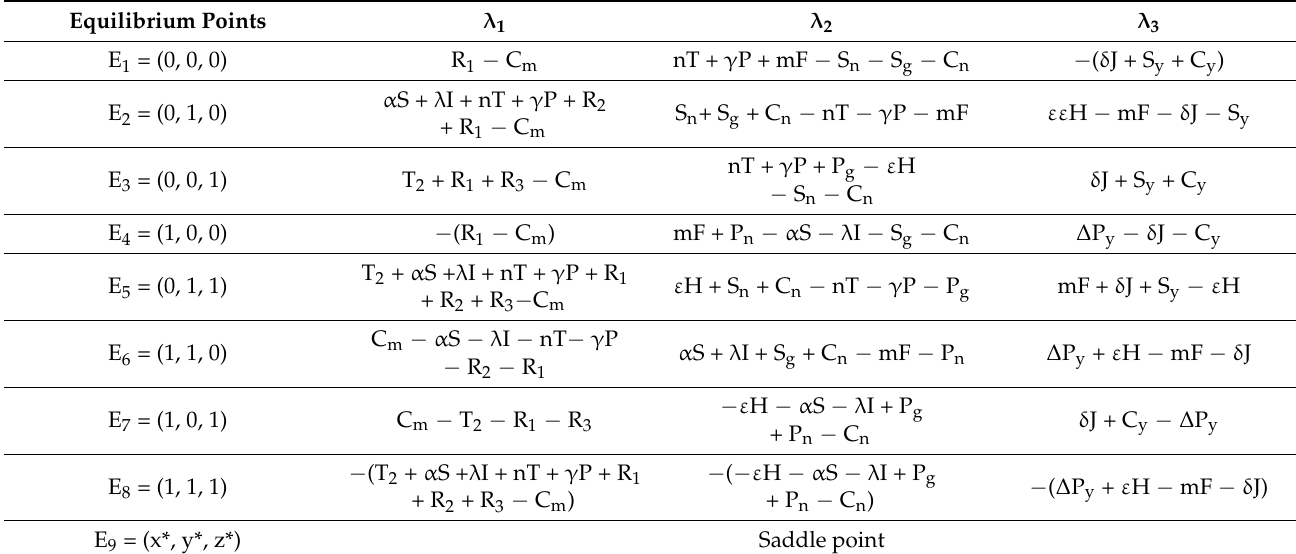
Table 3. Eigenvalues of Jacobi